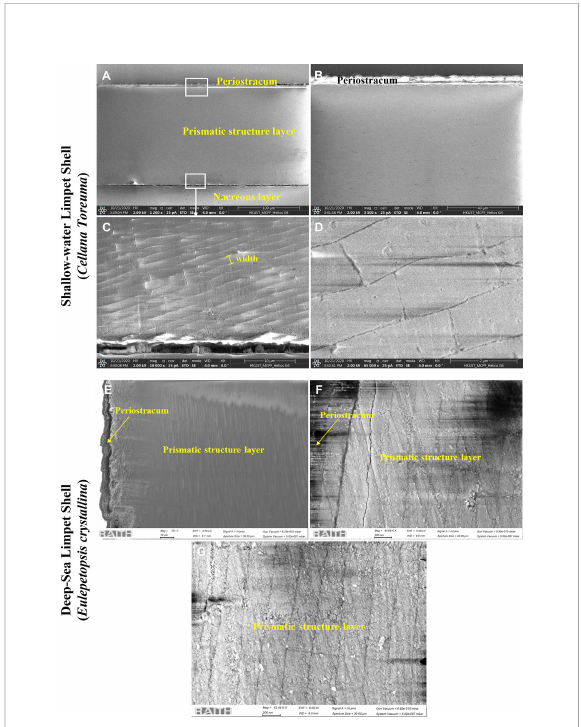
FIGURE 3 SEM images of the cross-sectional areas of shallow-water limpet C. toreuma shells prepared by FIB: (A) morphology of the cross- sectional layered structures. (B) The enlarged details of the relative area pointed by white rectangular frame (upper) in panel (A) . (C) The enlarged details of the relative area pointed by white rectangular frame (bottom) in panel (A) . (D) The high- magni fi cation details of the prismatic structure layer in panel (C) ; SEM images of cross-sectional areas of deep-sea limpet E. crystallina shells prepared by FIB: (E) morphology of the cross- sectional layered structures. (F) The enlarged details of